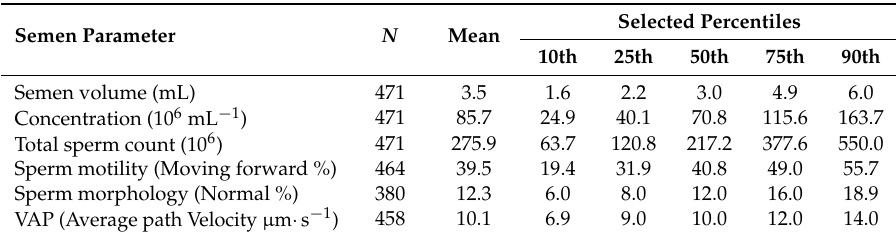
Table 1. Distribution of semen quality parameters in the present study.